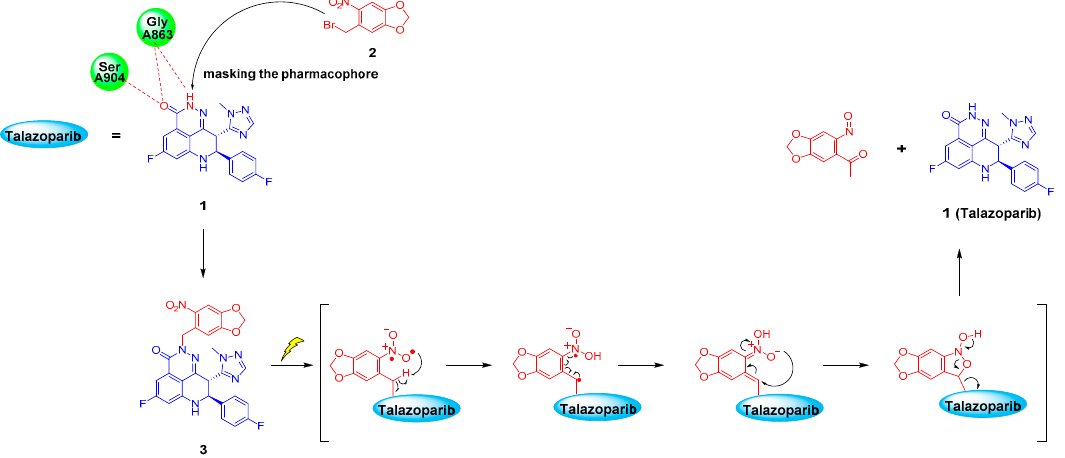
Figure 1. Photolysis mechanism of o-nitrobenzyl upon 365 nm UV irradiation and the inferred drug release process of the Talazoparib prodrug.